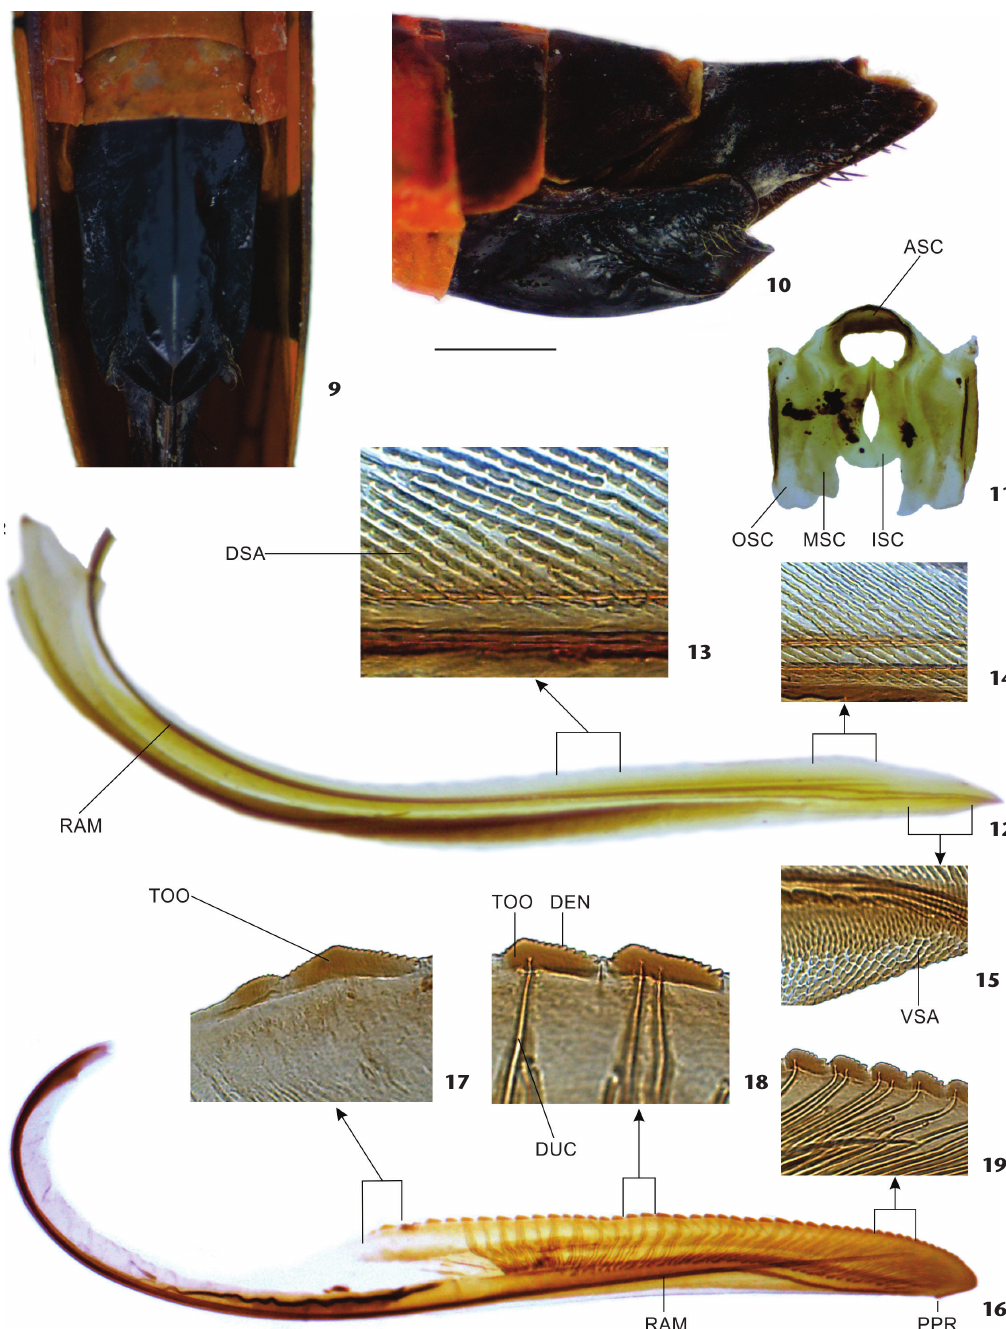
Figures 9-19. Cardioscarta splendida sp. nov. , female from Peru (see remarks): (9-10) apical portion of abdomen: (9) ventral and (10) lateral view (with scale bar); (11) “internal” sternite VIII, dorsal view; (12-15) valvula I: (12) lateral view; (13) median portion of dorsal sculptured area; (14) apical portion of dorsal sculptured area; (15) ventral sculptured area; (16-19) valvula II: (16) lateral view; (17) teeth at basal portion; (18) teeth at median portion; (19) teeth at apical portion. Abbreviations: (ASC) anterior (arc-like) sclerite; (DEN) denticle; (DSA) dorsal sculptured area; (DUC) duct; (ISC) inner sclerite; (MSC) median sclerite; (OSC) outer sclerite; (PPR) preapical prominence; (RAM) ramus; (TOO) tooth; (VSA) ventral sculptured area. Scale bar: 1